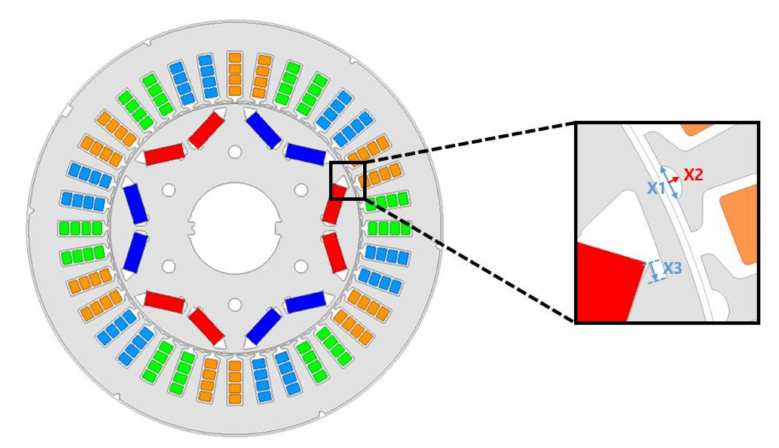
Figure 4. Optimal design